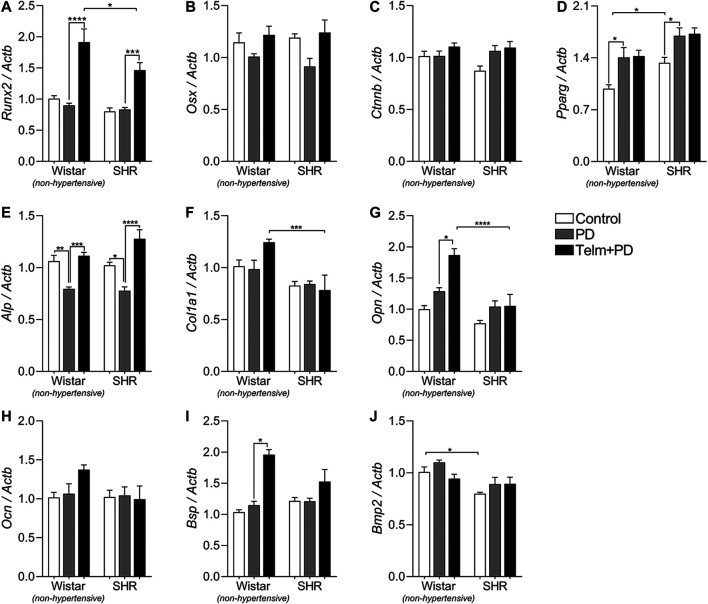
Bone formation markers expression in mandibles of Wistar (non-hypertensive) and SHR with PD 15 days, treated with telmisartan. qRT-PCR for Runx2
(A), Osterix
(B), Catnb
(C), Pparg
(D), Alp
(E), Col1a1
(F), Opn
(G), Ocn
(H), Bsp
(I), and Bmp2
(J). Graphs shown mean ± SEM (n = 6). Statistical difference are represented by brackets labeled by *p < 0.05, **p < 0.01, ***p < 0.001, and ****p < 0.0001, comparing Control vs. PD, PD vs. Telm + PD, and Wistar vs. SHR in the same experimental condition.